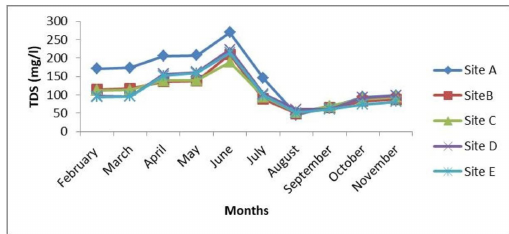
Figure 5. Monthly mean variations in biochemical oxygen demand of Nasarawa Reservoir.